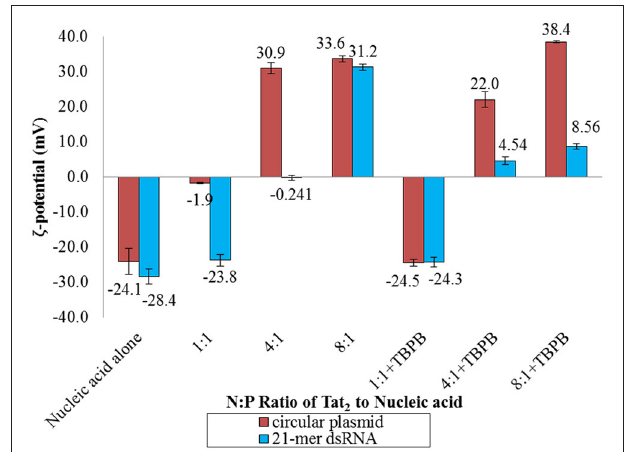
FIGURE 4 | Zeta ( ζ ) potential analysis of circular plasmid and dsRNA samples with and without TBPB in MM medium at the 1:1, 4:1, and 8:1 N:P ratios with Tat 2 . Circular plasmid was preferred over the linear dsDNA due to the higher concentration required for zeta-potential measurements. Numbers displayed are the values of the bars in mV. Data displayed represent means ± s.d. calculated from triplicate measurements.